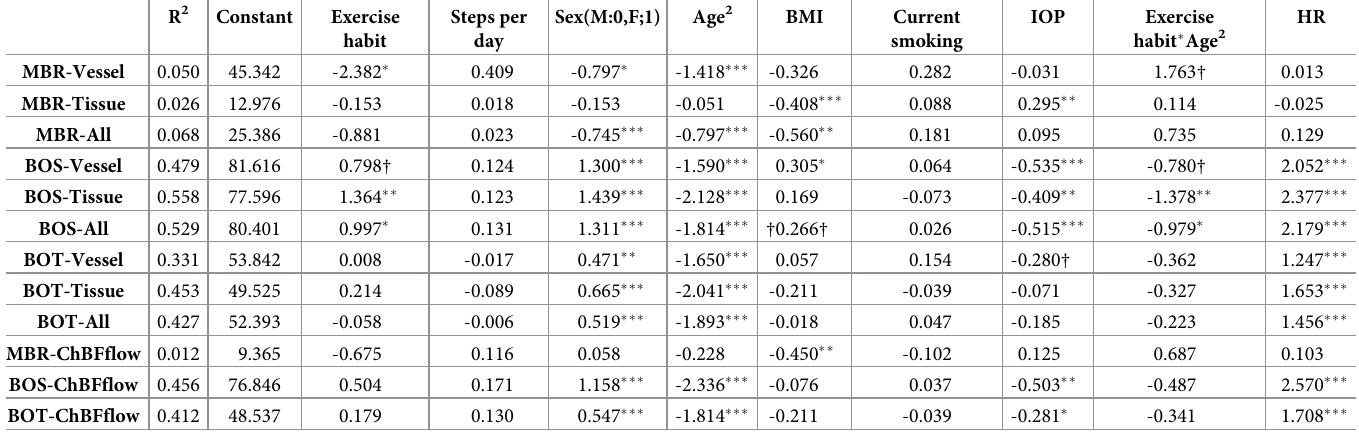
shown by an interaction in BOT-All and a marginally significant interaction (p = 0.055) in BOS-Tissue of age and MHLW-based exercise habits. BOS-Tissue and BOT-All of the elderly were lower in the Ex group than in the Non-ex group. The results suggest that the stiffness of ocular vessels cannot be improved by exercise habits. Table 6. Results of the multiple regression analysis for factors independently contributing to the item of ocular microcirculation, using the MHLW-based exercise habit. R 2